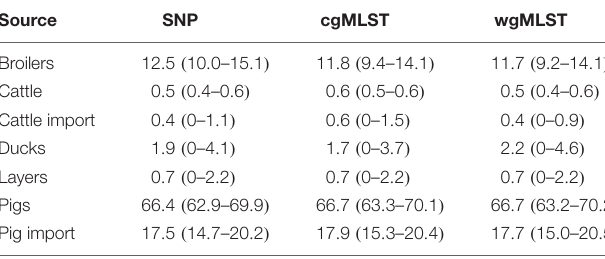
TABLE 8 | Mean probability (expressed in percentage) of a human isolate to be attributed to a source, together with confidence intervals, calculated for each of the considered pairwise distance matrices (SNP, cgMLST, and